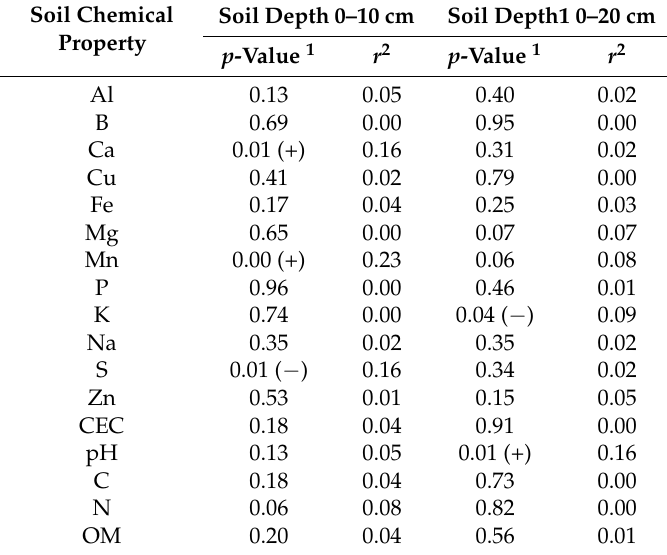
Table 2. Linear regression p -values and r 2 values for the prediction of soil chemical properties with fire frequency from 2004 to 2015 at the Tom Yawkey Wildlife Center, Georgetown, SC,